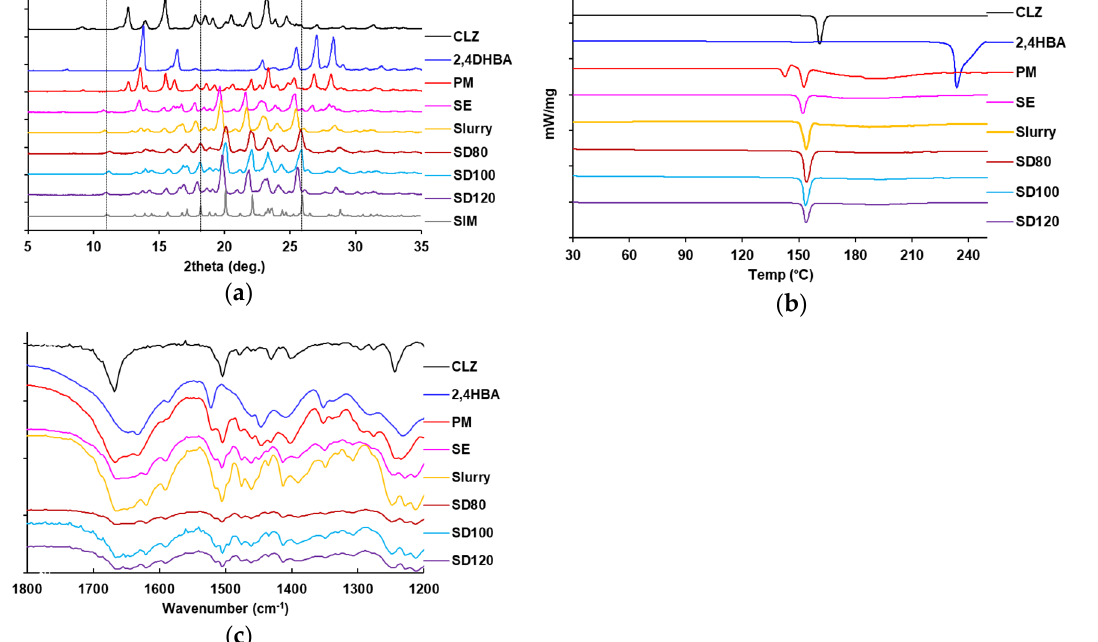
Figure 4. ( a ) PXRD, ( b ) DSC, and ( c ) FT-IR analysis of the CLZ-2,4DHBA cocrystals prepared using the solvent evaporation method, slurry method, or spray drying method.